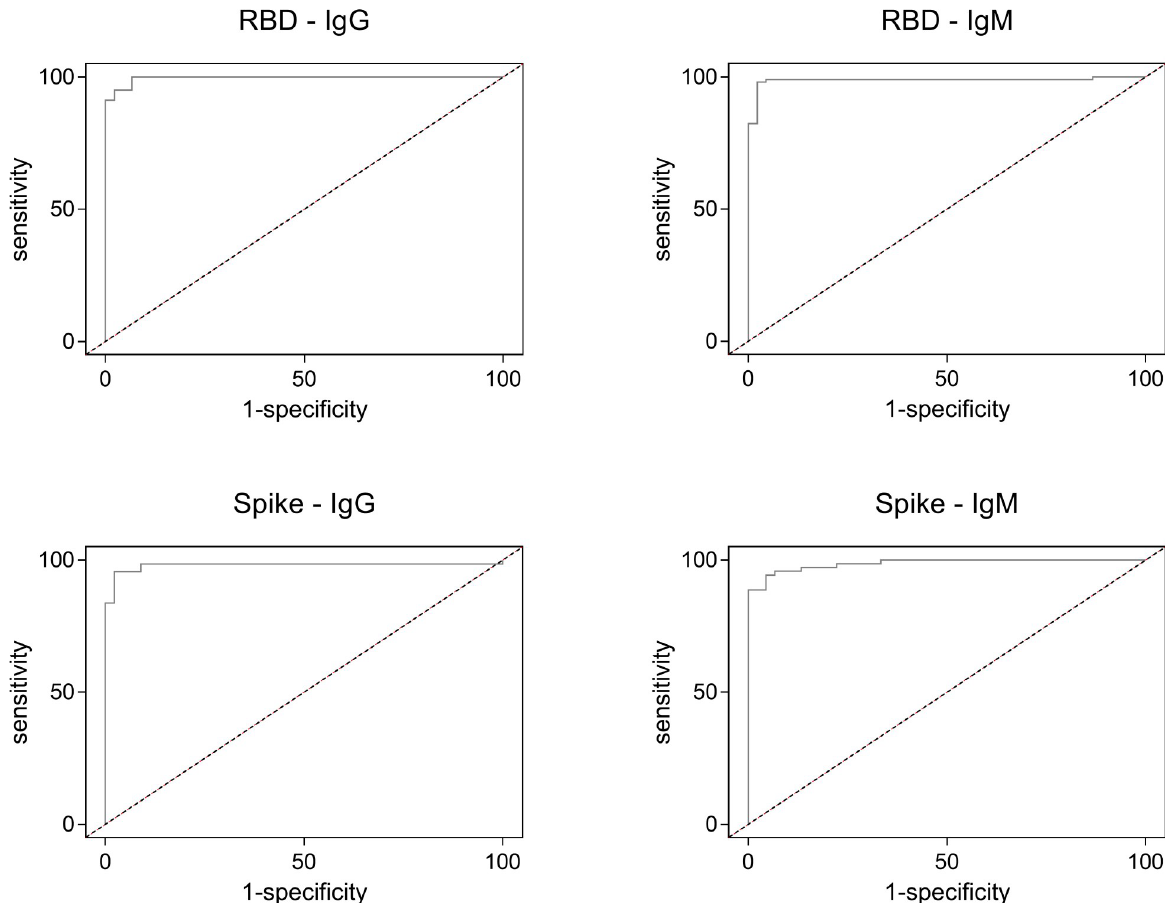
Fig 2. Performance of the described ELISA tests by receiver-operating characteristic (ROC) analysis. RBD: recombinant spike receptor binding domain. Spike: recombinant full Spike protein. Dotted lines represent the theoretical performance of a test with no discriminatory ability, corresponding to an area under the curve (AUC) of 0.5.